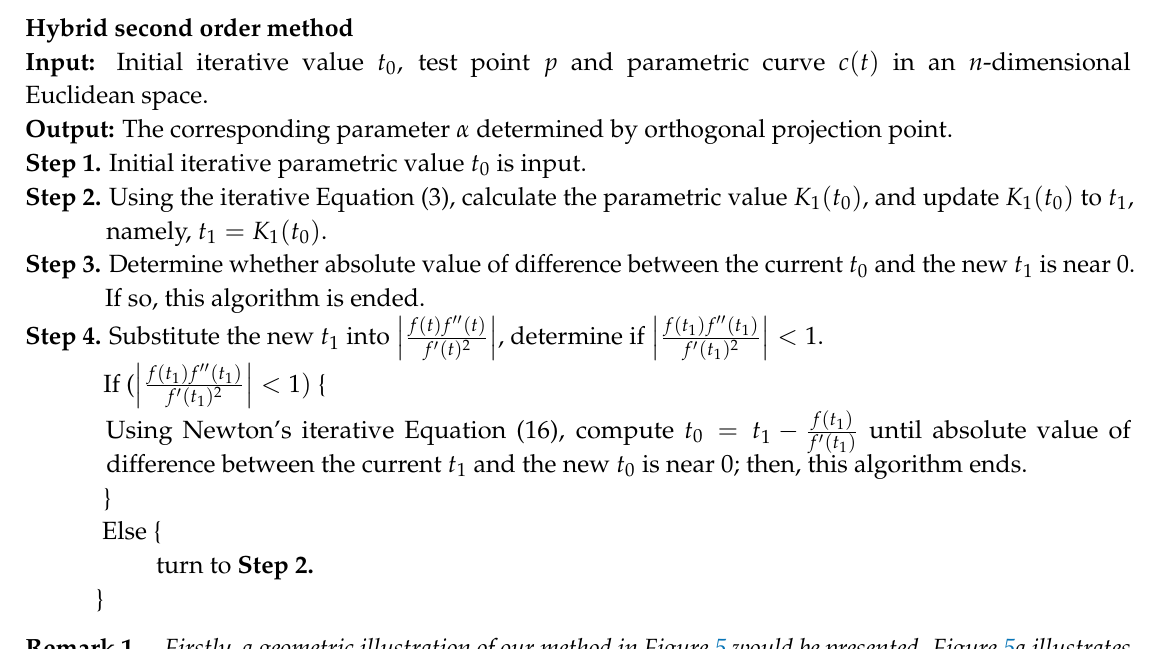
Figure 5. Geometric illustration for our method. ( a ) Running the H-H-H method; ( b ) Judging the H-H-H method whether being satisfied the convergence condition of fixed point theorem for the Newton’s iterative method; ( c ) Running the Newton’s iterative